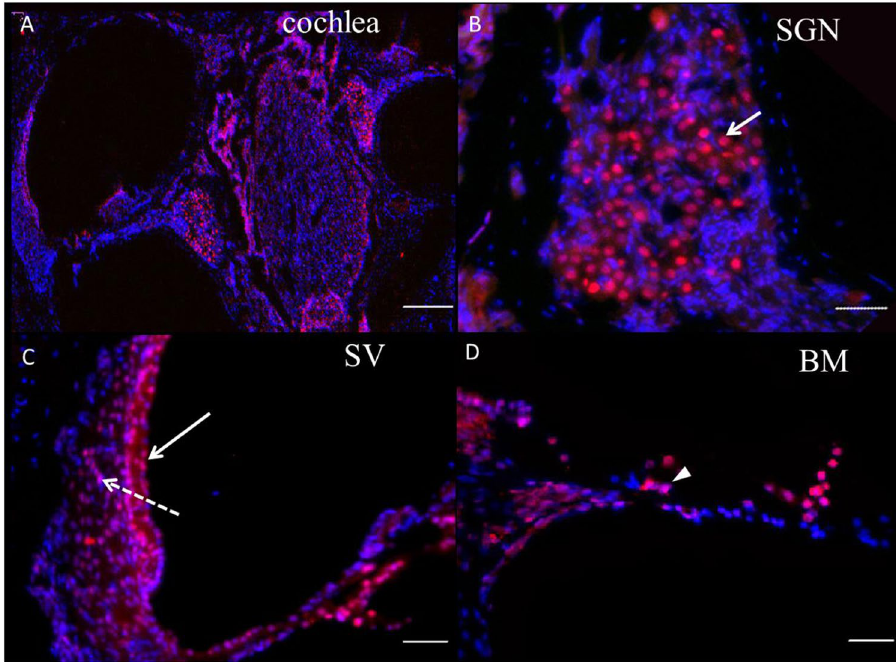
Figure 3. Examples of HDAC2 immunolabeling in cochlear cryosections. Low magnification of HDAC2 immunolabeling is shown in A. Strong HDAC2 positive labeling (red) was detected in the spiral ganglion neurons (SGN, arrow in B), in the stria vascularis (SV , long arrow in C) and in the organ of Corti ( arrowhead in D). Most cells in the spiral ligaments ( dashed arrow ), in the basilar membrane (BM) and in the spiral lamina (in D) showed weak positive labeling. The nuclei were stained by DAPI (blue). Scale bars = 250 μ m in A; = 50 μ m in B–D.